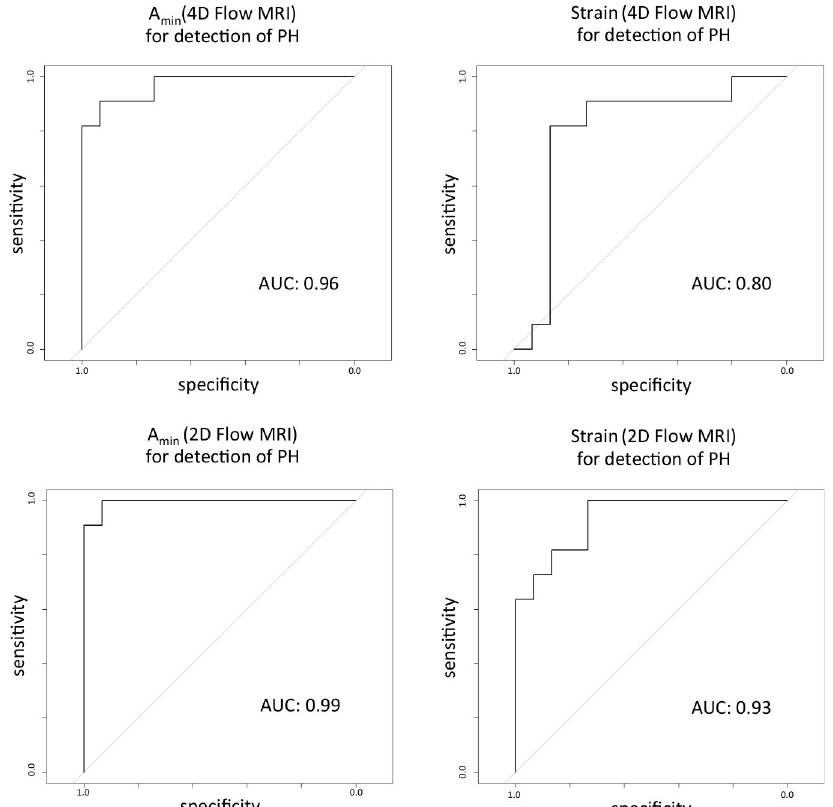
Fig 2. Receiver operating characteristic curves for A min and Strain measured with 4D and 2D Flow MRI. The ROC curves illustrate the ability of A min and Strain to detect patients with PH, characterized by a mean pulmonary artery pressure of > 25 mmHg. AUC = area under the curve.